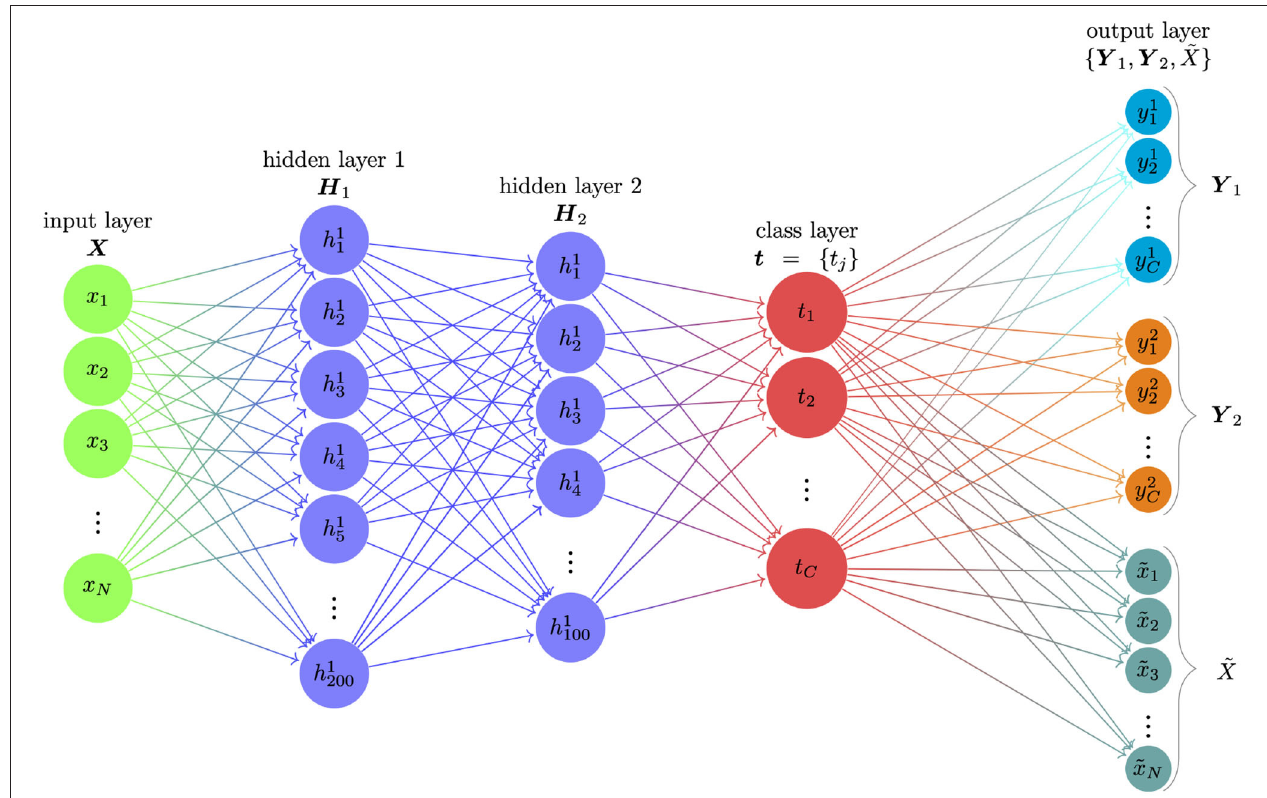
FIGURE 1 | The structure of the proposed semi-supervised learning ANN. The proposed semi-supervised learning ANN consisted of one input layer, two hidden layers, one class layer and one output layer. The input X is response pattern of a test-taker; H 1 and H 2 are two hidden layers; t indicates the class layer; and the output layer consists of three parts: Y 1 is the classification under DINA assumption; Y 2 is the classification under DINO assumption; ˜ X is the reconstructed response pattern of the